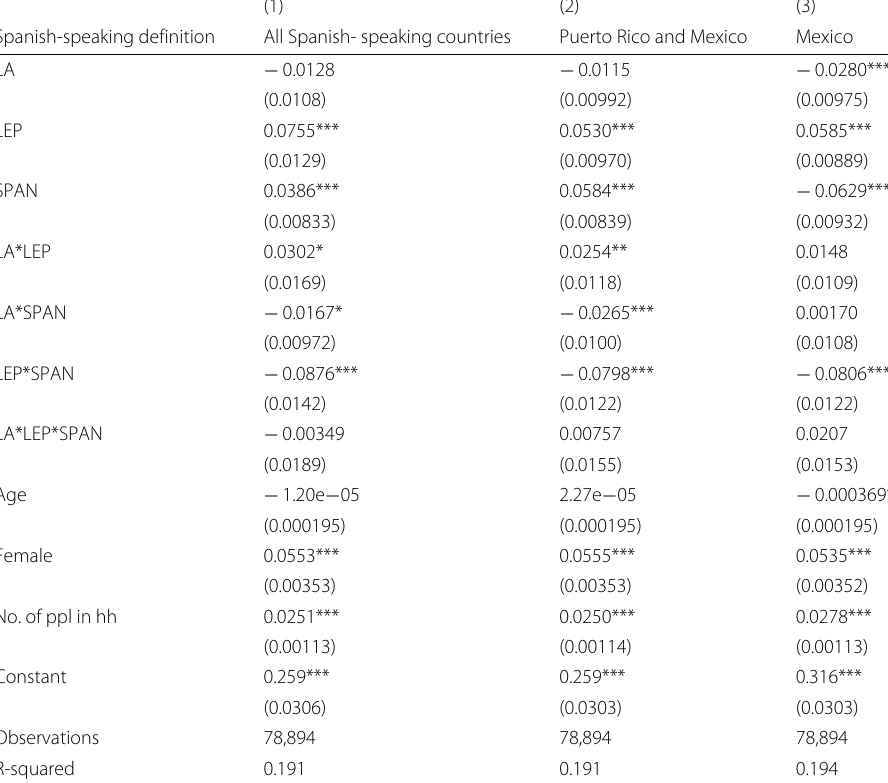
Table 8 Language access and Medicaid take-up rates: Spanish